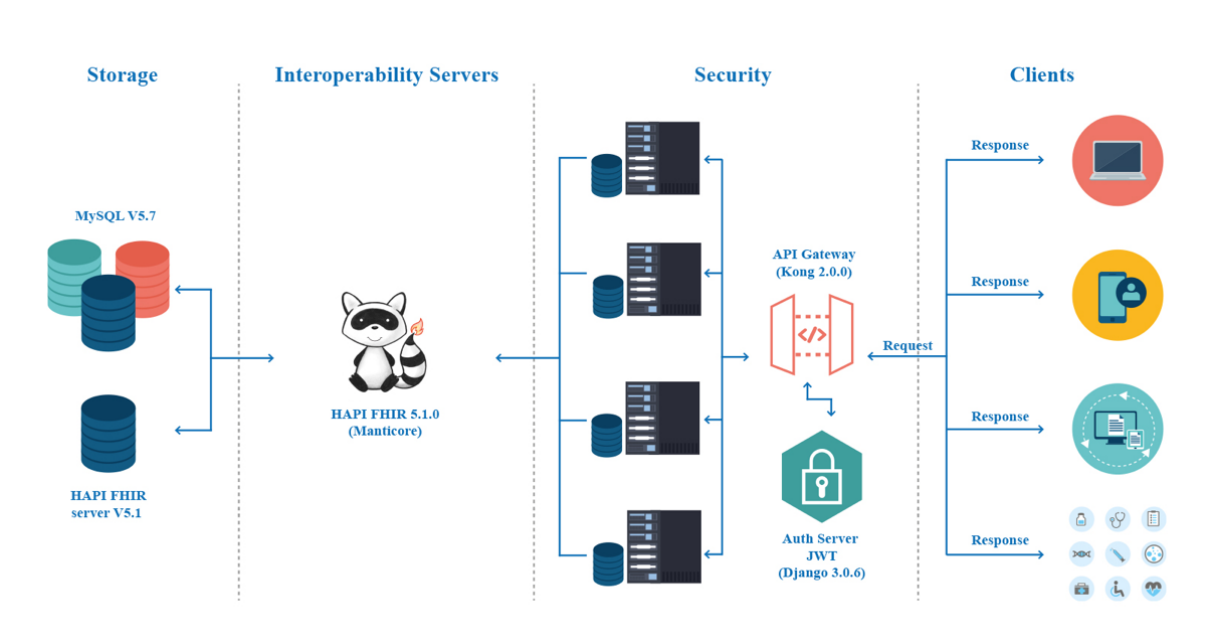
Figure 2. Layers of an interoperability architecture. The architecture for sharing the polymerase chain reaction SARS-CoV-2 tests from laboratories to the Chilean government. API: application programming interface; FHIR: Fast Healthcare Interoperability Resources; JWT: JavaScript Object Notation Web